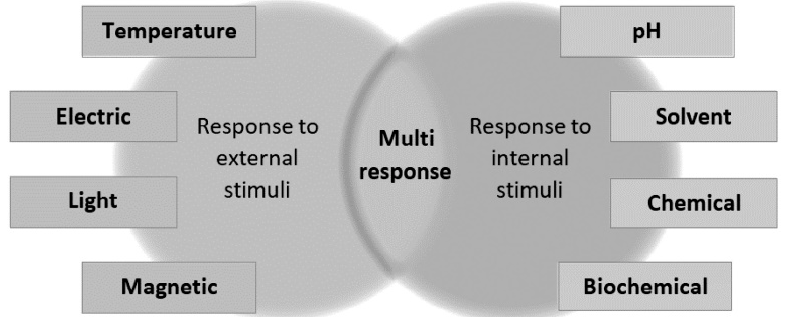
Figure 6. Classification of the responsive nanocomposite (taken from